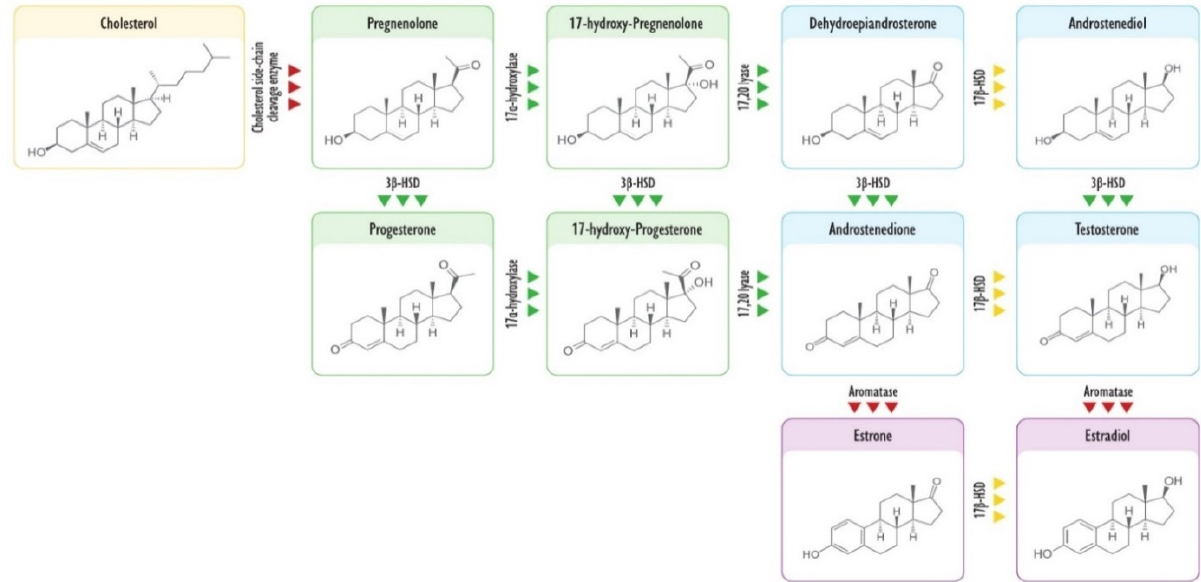
Figure 3. The figure reports the principal products of steroidogenesis and the enzymes involved. Yellow background depicts cholesterol; green background depicts progestogens; blue background depicts androgens; pink background depicts estrogens; green triangles indicate enzymes upregulated by DCI; yellow triangles indicate enzymes whose possible regulation by DCI is still unknown to date; red triangles indicate enzymes downregulated by DCI.